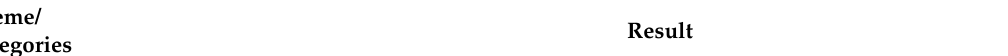
Table A5. Overview of themes and categories obtained from the reviewed articles relevant to patients for participating in a SDM process around total knee replacement